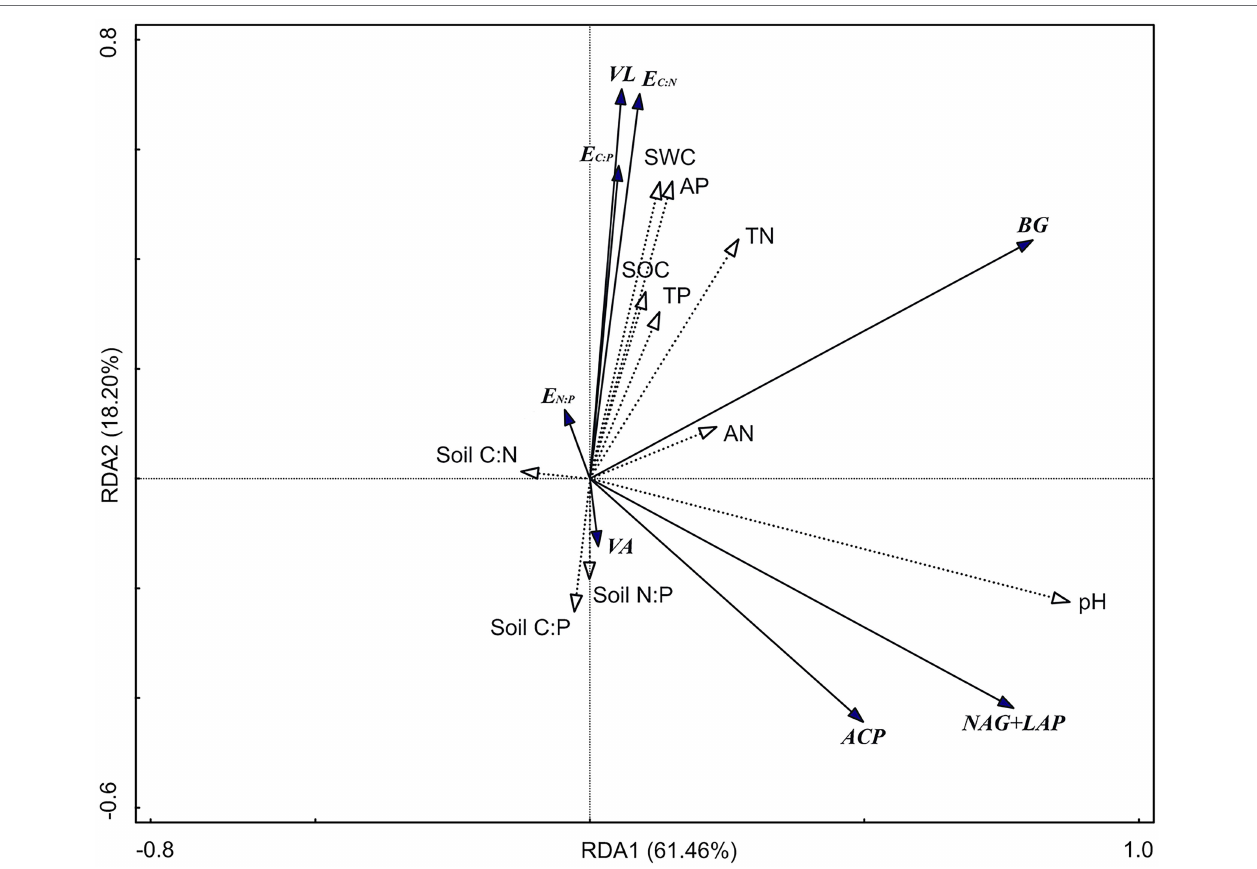
FIGURE 5 | Redundancy analysis (RDA) of soil enzyme activity and enzyme stoichiometric ratio. BG, Soil β -glucosidase; NAG + LAP, the sum of soil N -acetyl- β -d- glucosidase and soil leucine aminopeptidase; and ACP, soil acid phosphatase. E C:N , ln(BG):ln(NAG + LAP); E C:P , ln(BG):ln(ACP); E N:P , ln(NAG + LAP):ln(ACP); VL, vector length; VA, vector angle; SWC, soil water content; SOC, soil organic carbon; TN, total nitrogen; AN, available nitrogen; TP, total phosphorus; AP, available phosphorus; Soil C:N, the ratio of soil SOC to TN; Soil C:P, the ratio of soil SOC to TP; and Soil N:P, the ratio of soil TN to